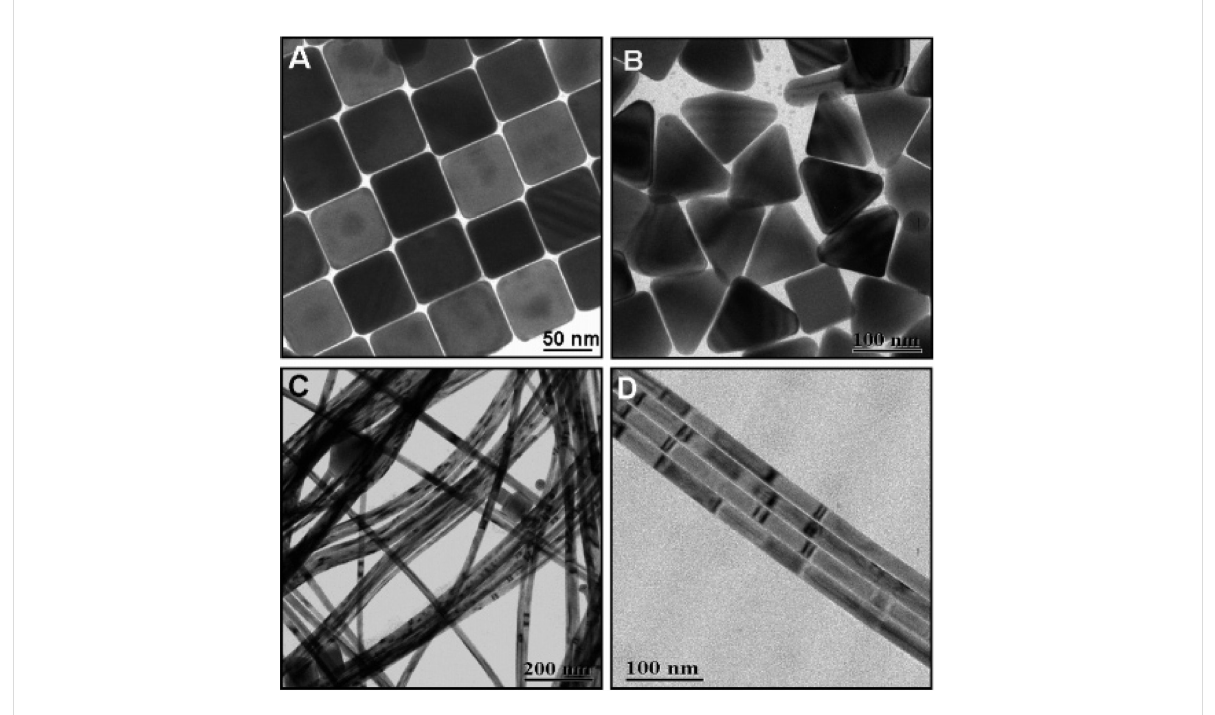
Figure 1: TEM images of Ag NPs: (a) cubes; (b) triangles; (c) wires; (d) an alignment of wires. Reproduced with permission from [145]; Copyright (2005) American Chemical